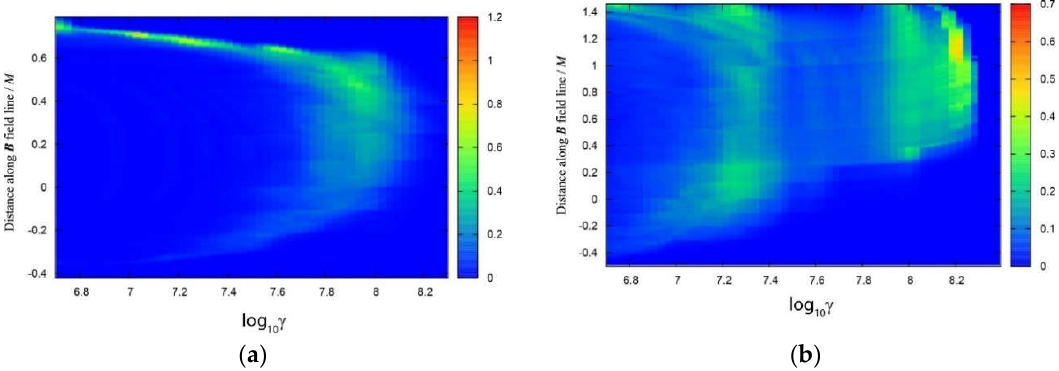
Figure 17. Electron distribution function, γ n − ( r , γ ) , of the electrons along the magnetic field line on the polar axis, θ = 0 ◦ , for a = 0.9 M and m = 1.77 × 10 −5 . The abscissa denotes the electron Lorentz while the ordinate denotes the distance from the null surface, s ≈ r − r 0 , along the poloidal magnetic field line, where the ordinate is converted into the Boyer–Lindquist radial coordinate. ( a ) The case of M = 10 9 M ʘ . ( b ) The case of M = 10 6 M ʘ . From [63].